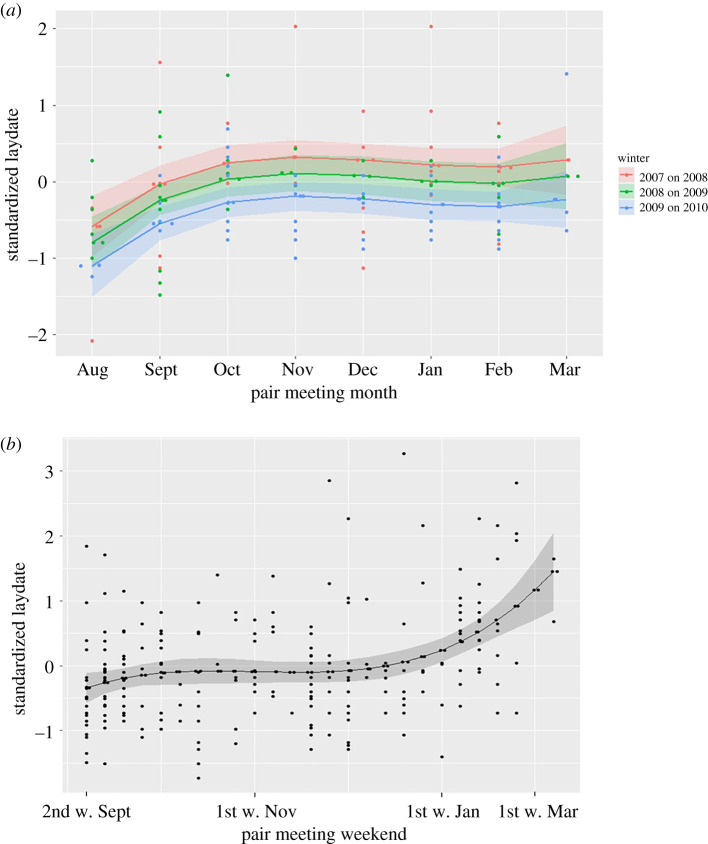
Standardized (for a year and for all breeding pairs) laydate of newly formed pairs of great tits as a function of meeting time of a pair in the preceding winter for (a) 2008 to 2010 breeding seasons, where meeting time was a month when a pair was first seen together; (b) 2012–2014 breeding seasons, where meeting time was a weekend when a pair was first seen together. Shaded areas represent 95% CI of the line. Dots represent the original data points. (Online version in colour.)